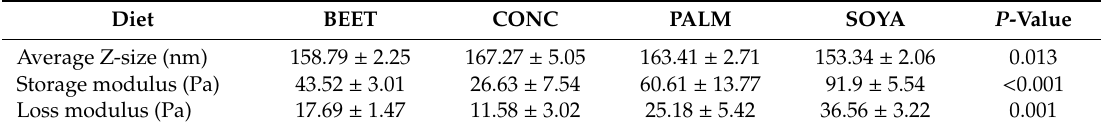
Table 10. Summary of e ff ect of diet on the casein micelle size and gel strength of milks derived from BEET, CONC, PALM, and SOYA. Diet BEET CONC PALM SOYA P -Value Average Z-size (nm) 158.79 ± 2.25 167.27 ± 5.05 Storage modulus